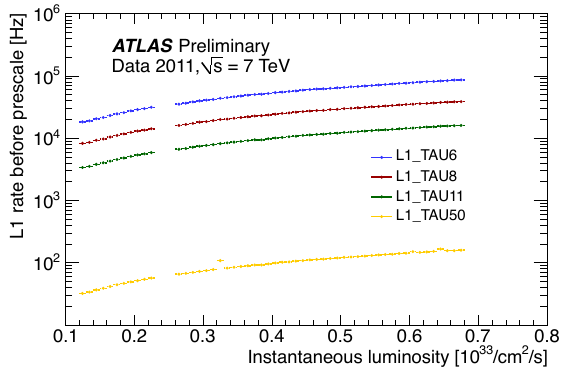
Fig. 5. Evolution of the event rate as a function of the instanta- neous luminosity for L1 items as measured in 2011 data [2].